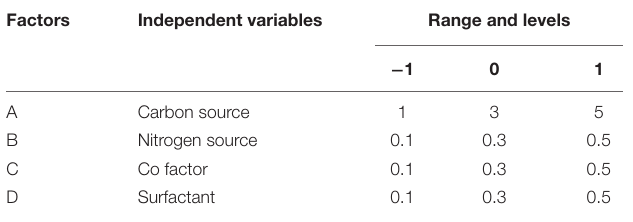
TABLE 1 | Experimental range and levels of the independent variables to optimize media components for protease production by Bacillus pumilus MP